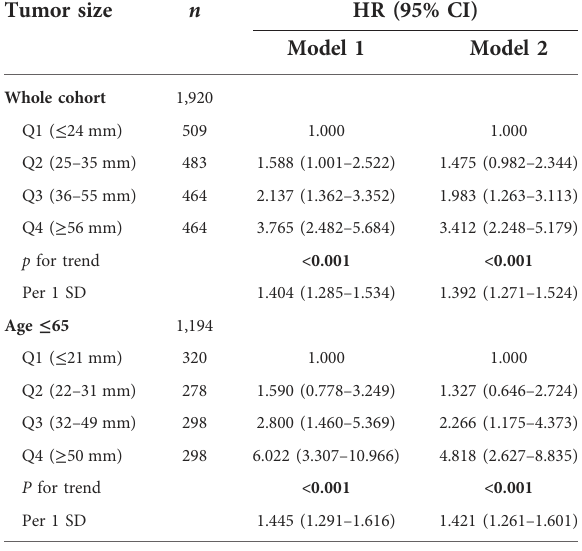
Model 1: Adjusted for age, sex. Model 2: Adjusted for age, sex, race, grade and marital